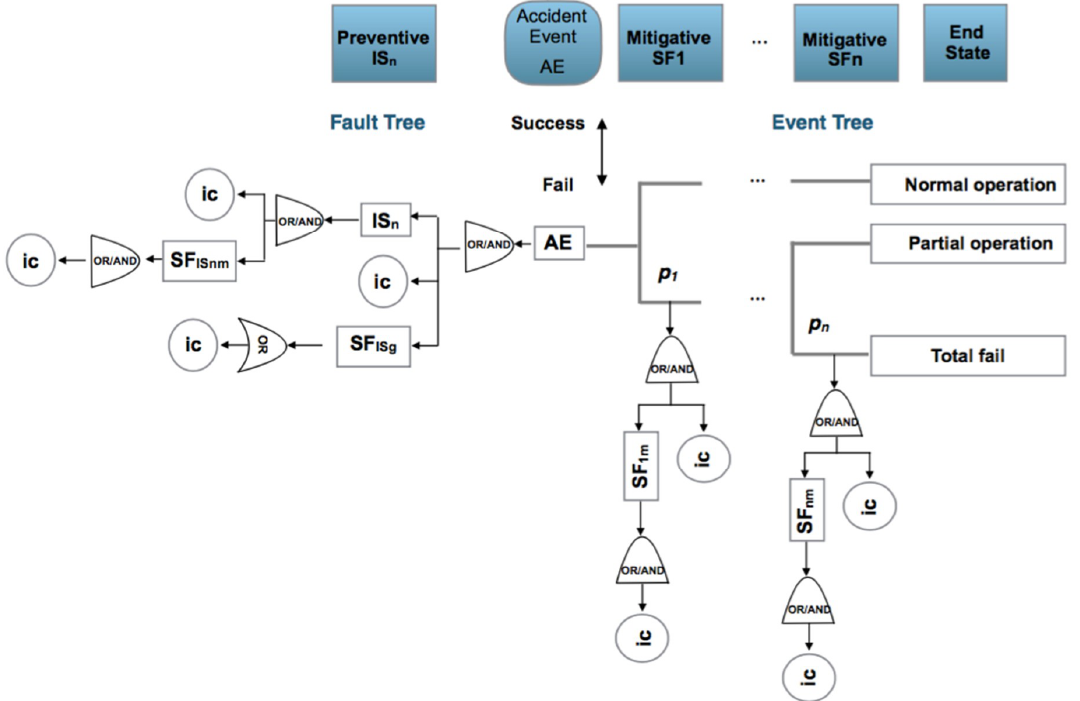
Figure 5. Safety barriers: IS n : preventive barrier (n); SF ISnm : preventive barrier (n) sub-function (m); SF ISg general sub-function safety barrier; SFn: mitigative barrier (n); SF nm : mitigative barrier (n) sub-function (m); ic: initiation causes (ba, ha, pot); p ,s,f : probability of success or fail in the mitigative or reactive safety barrier.